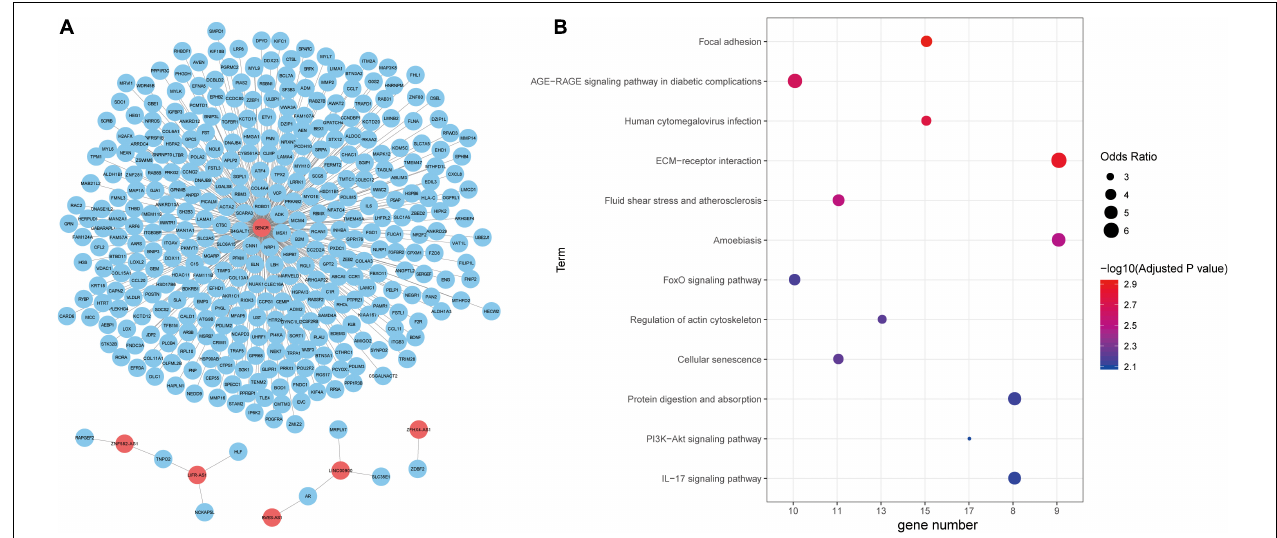
FIGURE 4 | Functional annotation of lncRNAs. (A) The unweighted network of lncRNA-mRNA pairs, including 370 nodes (6 lncRNAs and 364 mRNAs), 366 edges. Red nodes represent lncRNAs, blue nodes represent mRNAs. (B) Significant KEGG pathways derived from the Enrichr web